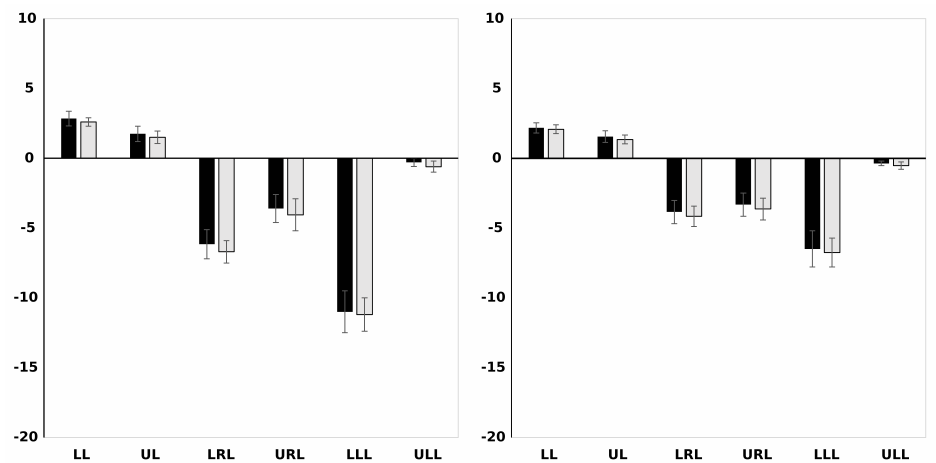
Figure 7. Lesion percentage bias for the six lesions for MC-OSSPS and R-MC-OSSPS. Left: without post-smoothing; right: with 6 mm Gaussian post-smoothing. Solid and hollow bars show the mean values for noisy data (10 noise realizations) with MC-OSSPS and R-MC-OSSPS, respectively. The error bars denote the standard deviation of the percentage bias values over the 10 noise realizations. The lesions are lower liver (LL), upper liver (UL), lower right lung (LRL), upper right lung (URL), lower left lung (LLL), and upper left lung (ULL).